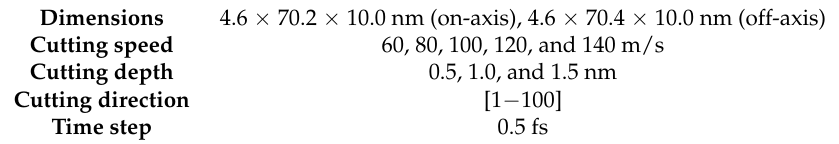
Figure 2. Three different silicon carbide (SiC) workpiece models. ( a ) 4 ◦ Off-axis toward [1 − 100]. ( b ) On-axis. ( c ) 4 ◦ Off-axis toward [ − 1100]. Table 1. Parameters used in the